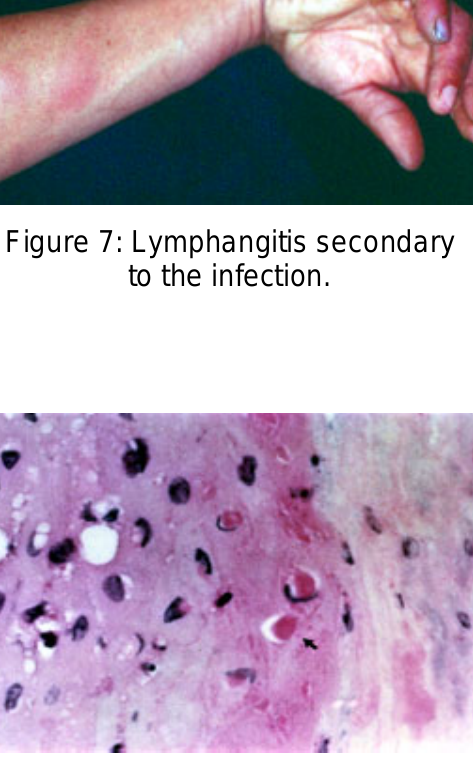
Figure 9: Keratinocytes with eosinophilic inclusions in the cytoplasm.